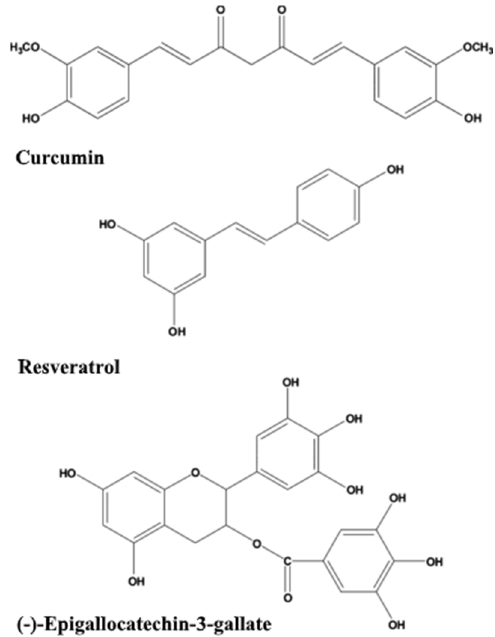
Figure 1. The structures of curcumin, resveratrol, and ( − )-epigallocatechin-3-gallate.